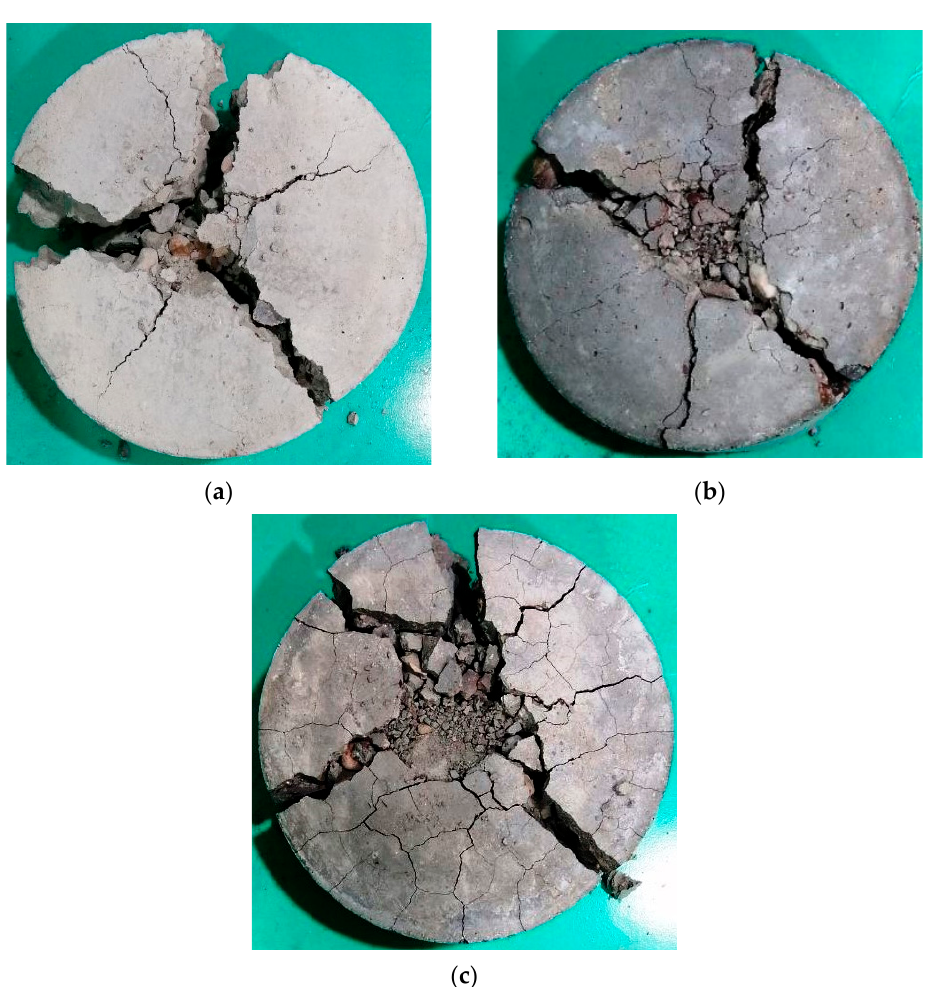
Figure 16. Failure patterns of cylindrical specimens heated to 400 °C: ( a ) M20, ( b ) M40, ( c ) M80.